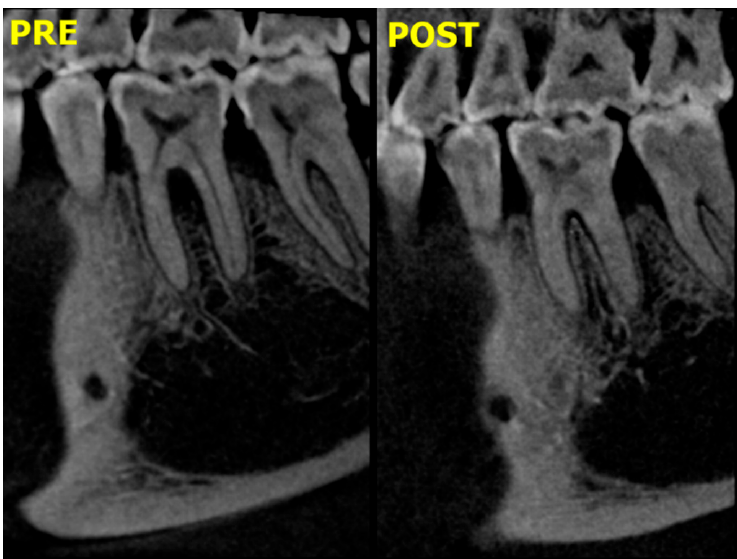
Figure 4. Sagittal view shows preoperative and postoperative furcation bone improvement. The mean values of furcation depth (D) and 3D furcation volume showed significant reductions across the study period ( p < 0.05) for both groups. For group I, the mean values of D and 3D furcation volume measurements decreased from 5.33 ± 0.90 mm and 13.79 ± 4.45 mm 3 , to 1.70 ± 0.54 mm and 7.18 ± 2.8 mm 3 , respectively; for group II, the mean values of D and 3D furcation volume measurements decreased from 5.52 ± 1.10 mm and 6.23 ± 1.5 mm 3 , to 2.03 ± 0.69 mm and 3.99 ± 0.52 mm 3 , respectively (Table 2, Figure 5). Table 2. The mean 3D furcation volume assessment (F in mm 3 ) values for groups 1 and 2 at baseline and at 6 months following surgery.